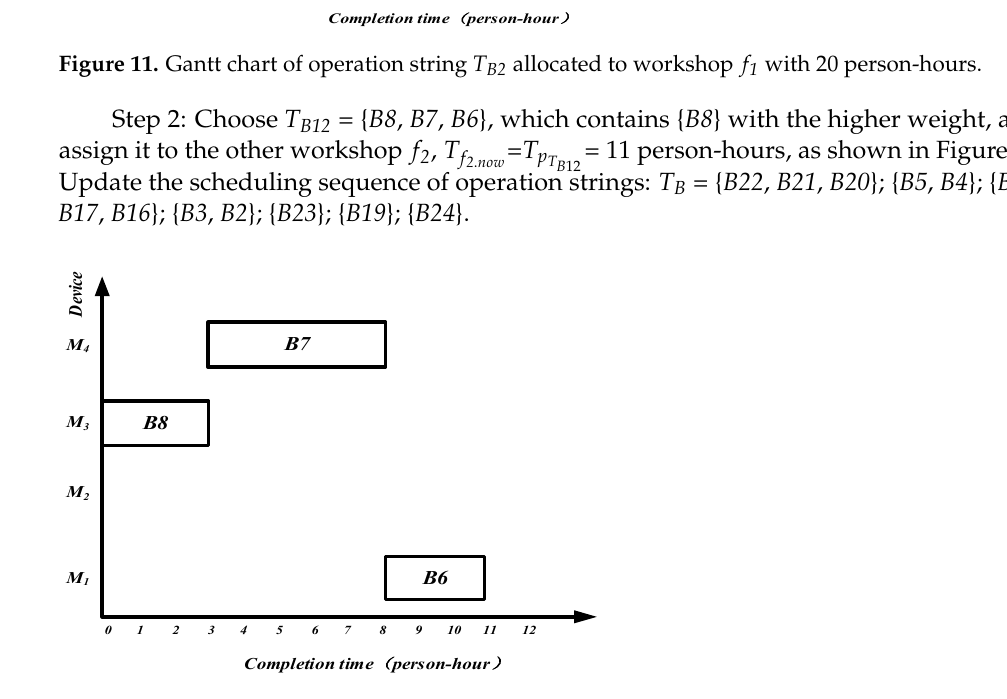
with 11 person ‐ hours. 2